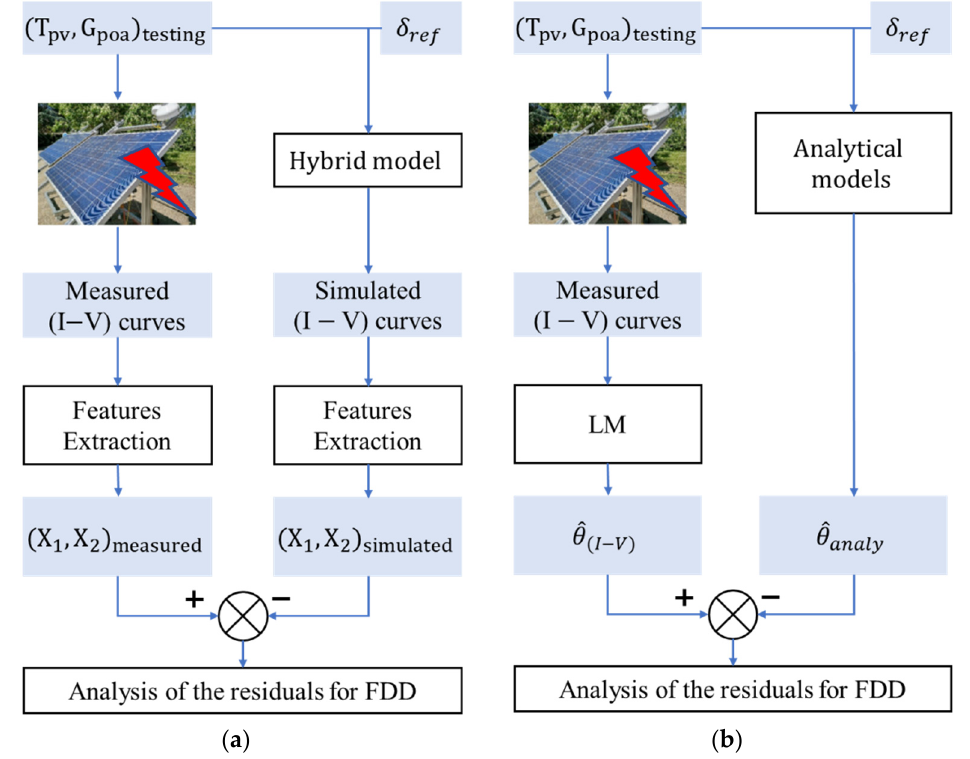
Figure 22. Flowchart of the FDD: ( a ) M1; ( b ) M2 .